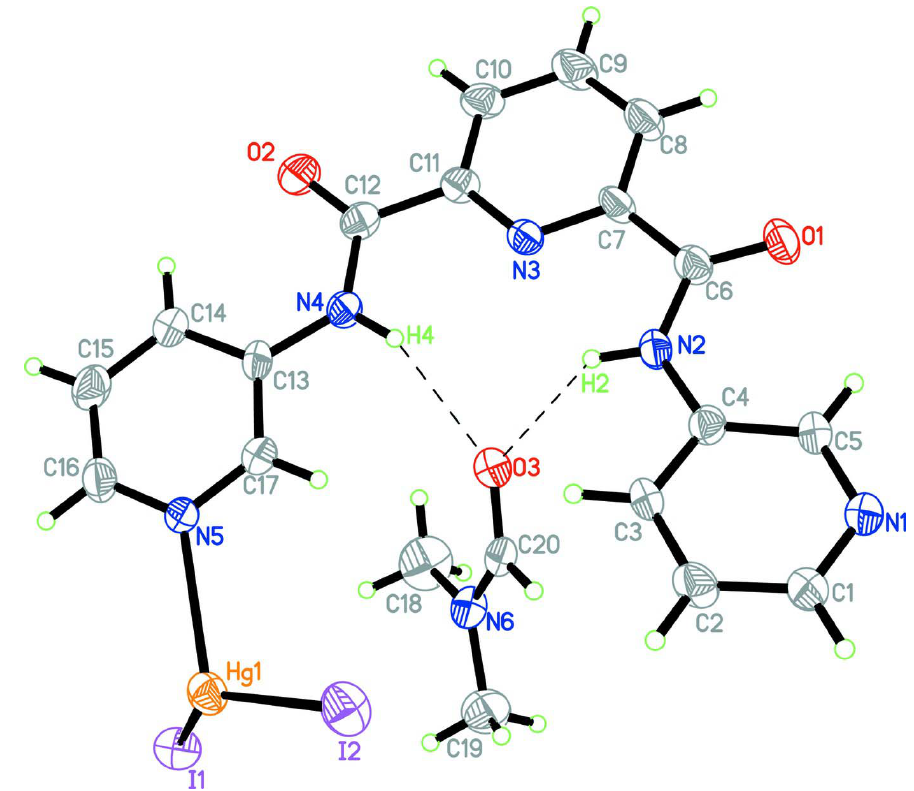
Figure 1 View of the title complex, showing the labeling of the non-H atoms and 30% probability